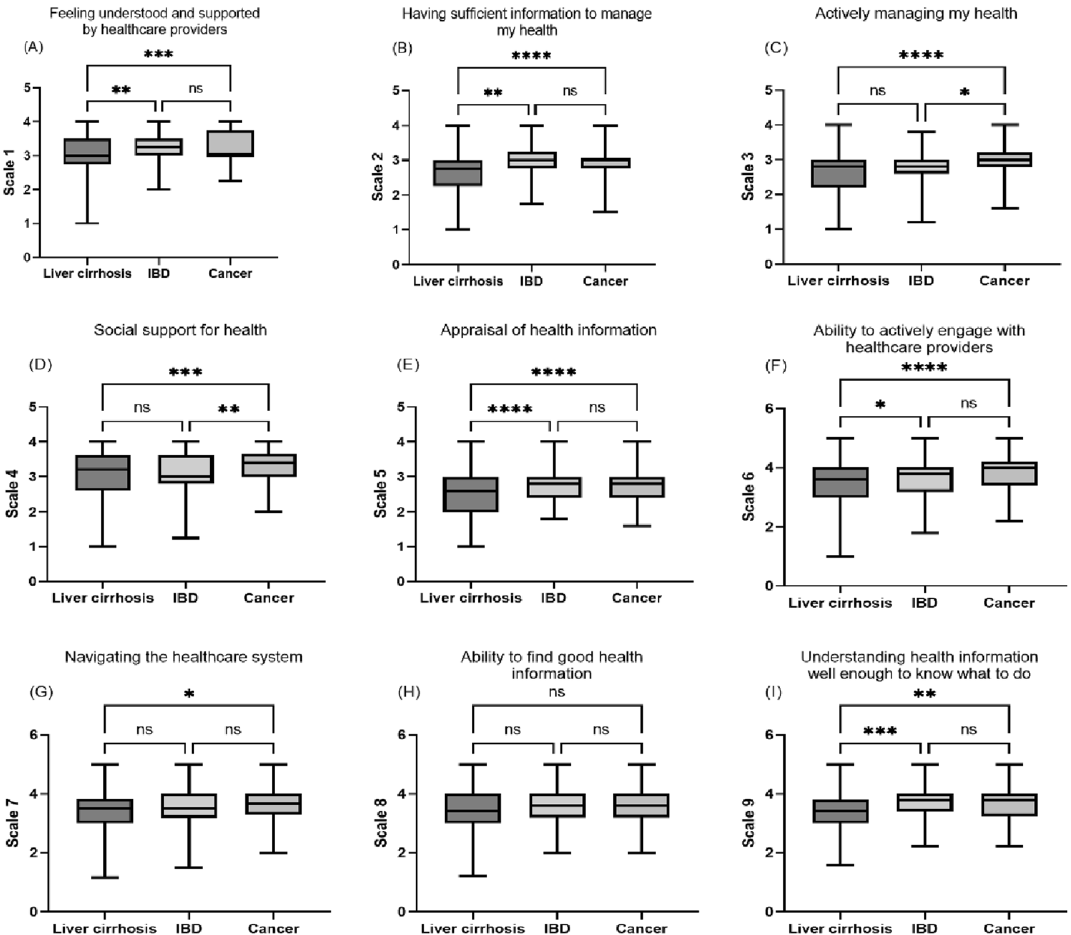
Figure 1. Comparison of the scores in the nine subscales of the HLQ between patients with liver cirrhosis, inflammatory bowel disease (IBD) and cancer. *p < 0.05, ** p < 0.01, *** p < 0.001, **** p < 0.0001, ns = not significant. Comparisons of three groups were performed using an ANOVA followed by Tukey’s multiple comparison